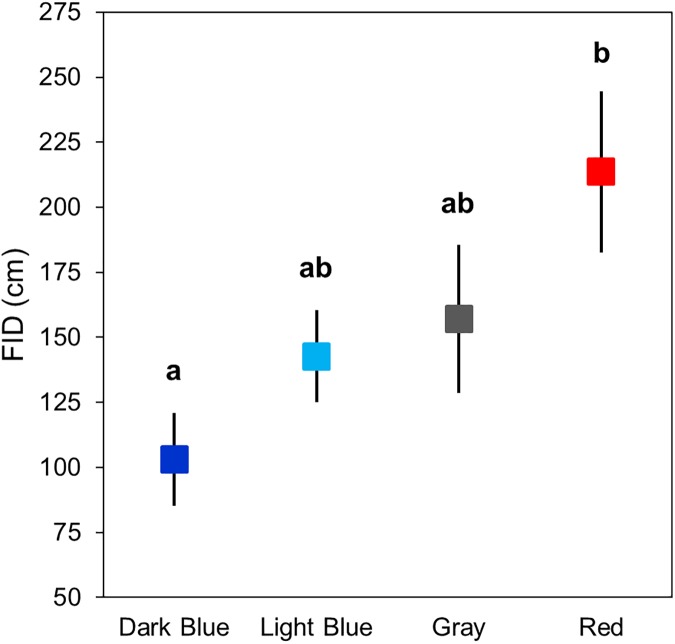
Mean ± SE flight initiation distance (FID) of lizards approached by a human wearing different colored T-shirts (data from both sites pooled).Letters denote significant (p < 0.05) differences among colors from post-hoc comparisons made using the false discovery rate.